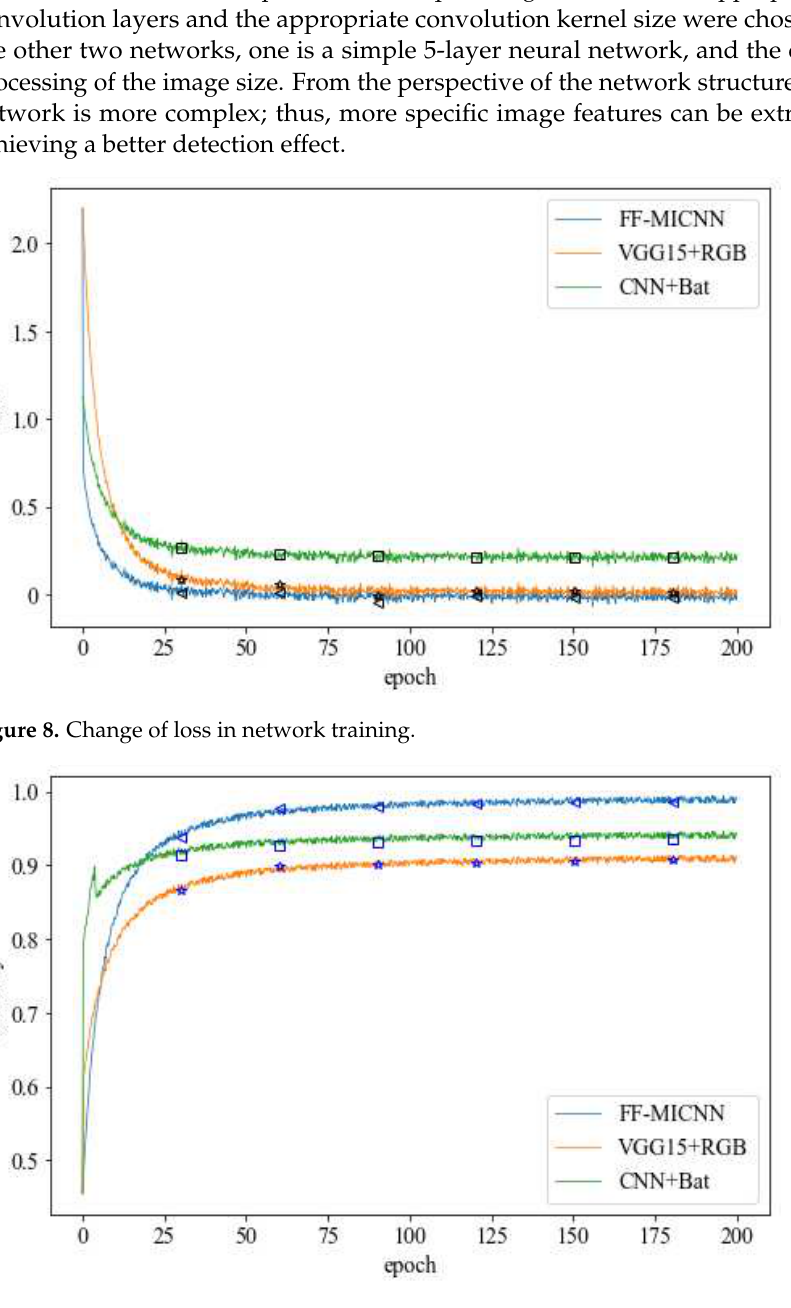
Figure 9. Change of accuracy in network